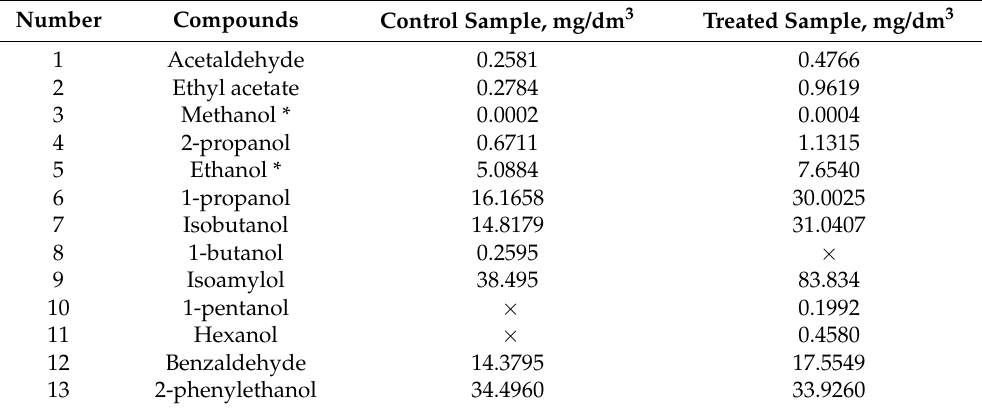
Table 6. Volatile compounds found in